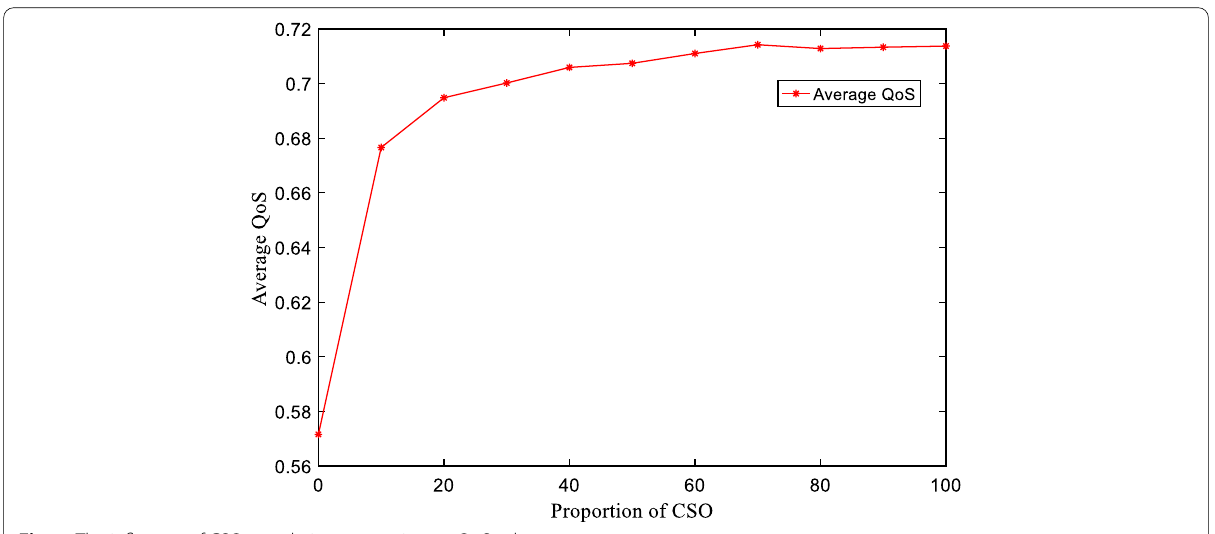
Fig. 5 The influence of CSO population proportion on QoS